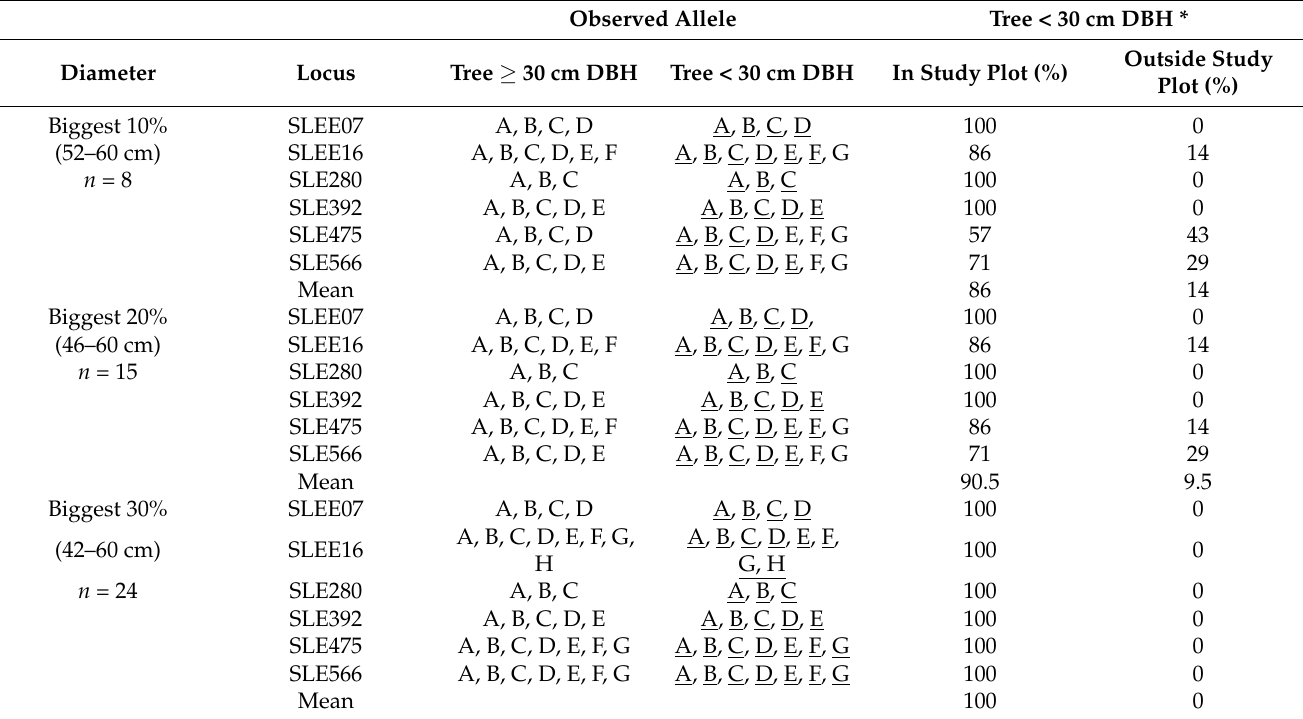
Table 4. Maternal contribution for S. accuminata according to percentage of the biggest tree in compartment 107, Kenaboi FR. The underlined allele is probably the allele from big S. acuminata in the study plot. Observed Allele Tree < 30 cm DBH *